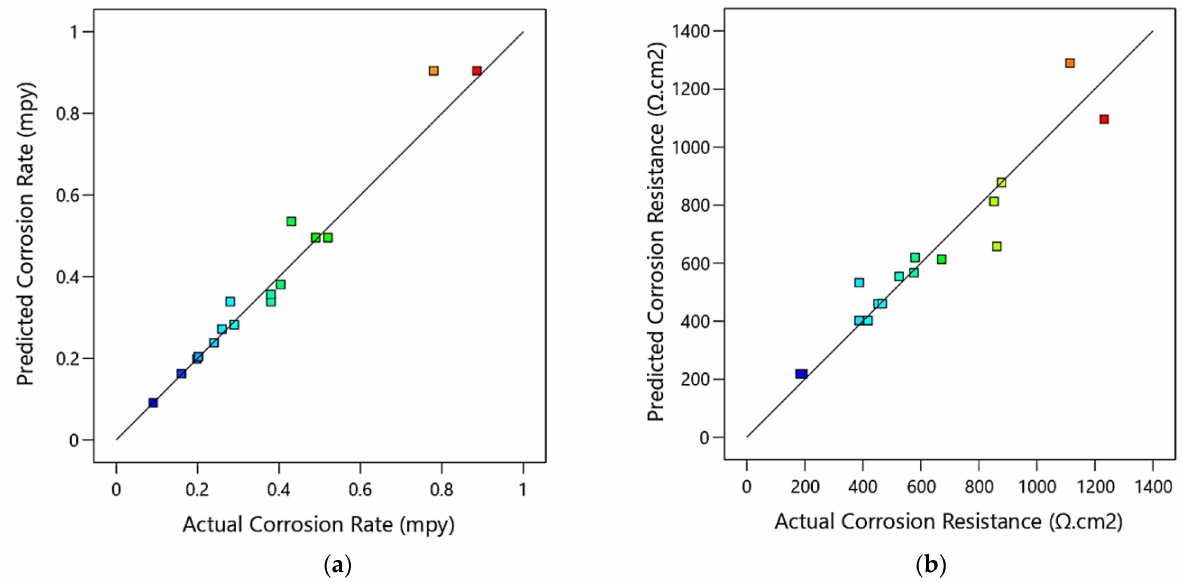
Figure 6. Predicted versus actual values of the ECAP corrosion rate ( a ) and corrosion resistance ( b ), where the blue points are for minimum output value and gradually changed to red points for maximum output